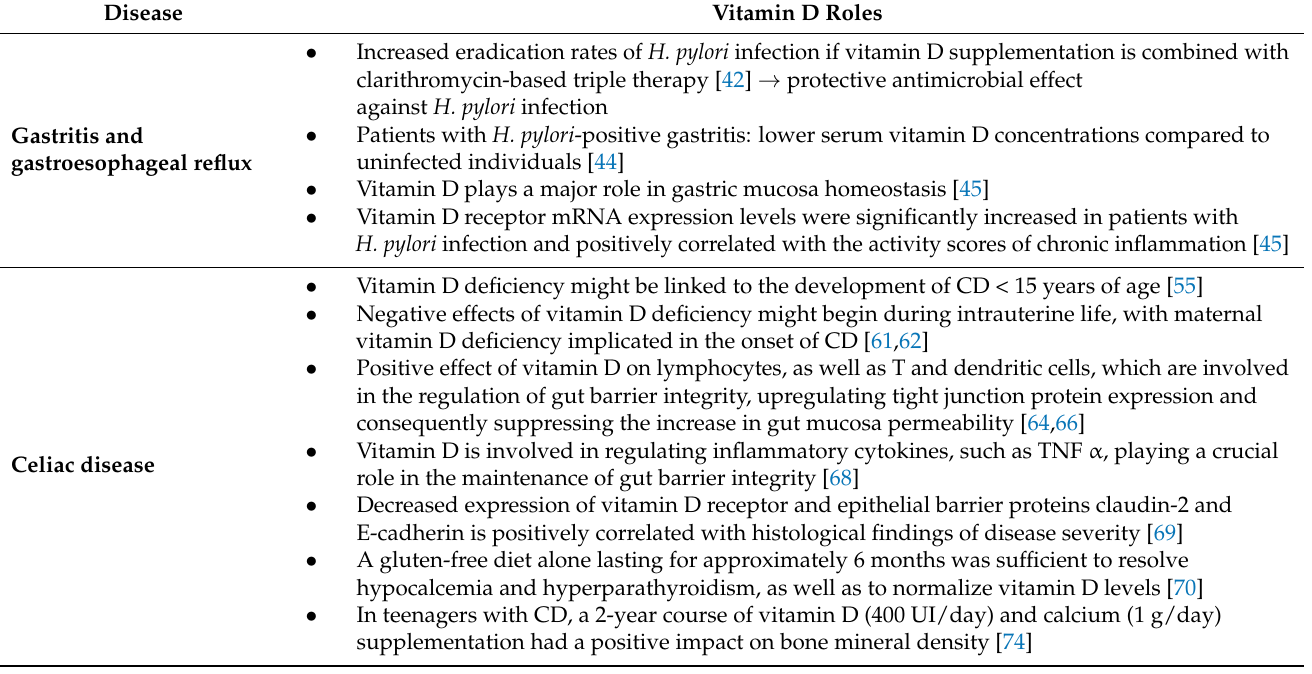
Table 1. The role of Vitamin D in pediatric digestive